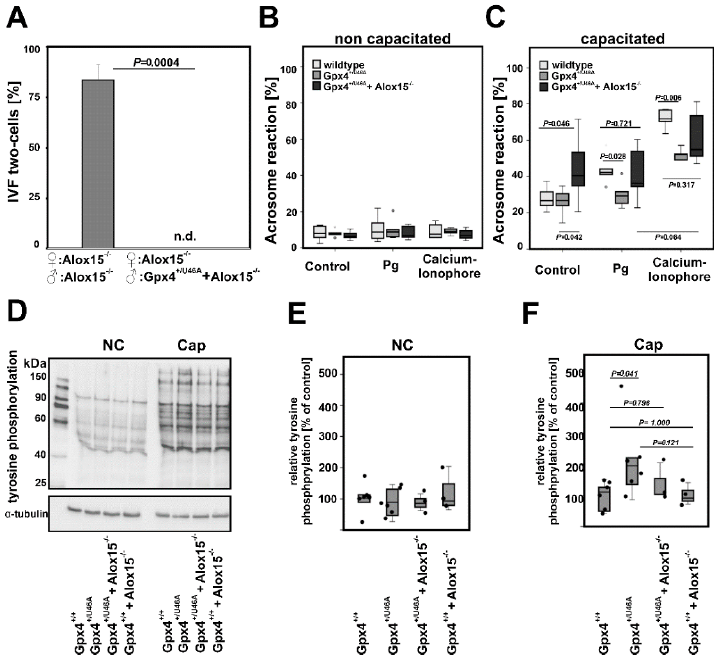
Figure 6. Impact of sperm Alox15 deficiency on the success rate of in vitro fertilization and the extent of the acrosome reaction. ( A ) In vitro fertilization of Alox15-deficient oocytes (Alox15 −/− ) with sperm prepared from Alox15 −/− mice (left column) and Alox15 −/− + Gpx4 +/U46A (right column) animals. Cu- mulus-oocyte complexes (COCs) were isolated from female Alox15 −/− mice and were fertilized in vitro with sperm extracted from males of the same genotype (left column). Next, we employed the same oocytes and attempted to fertilize them in vitro with sperm prepared from Gpx4 +/U46A +